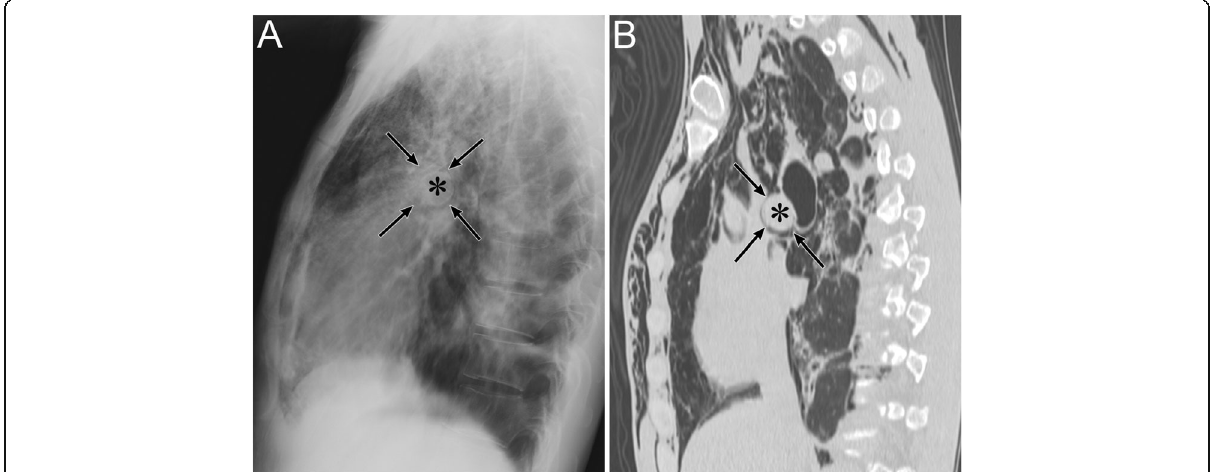
Fig. 14 Pneumomediastinum of a 43-year-old man with acute myelogenous leukemia. a Erect lateral radiograph shows the “ ring around the artery ” sign. b A sagittal CT image also shows a lucent ring (arrows) surrounding the right pulmonary artery (asterisk), a feature called the “ ring around the artery ” sign